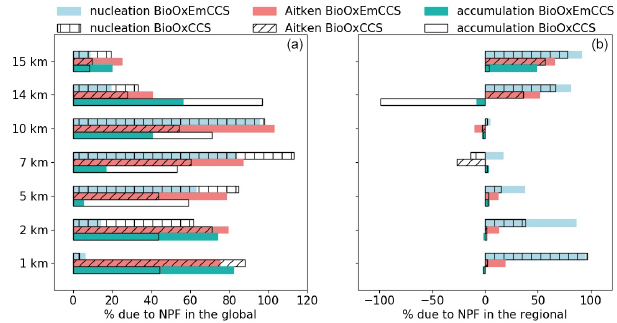
Figure 9. The percentage contribution of NPF to the nucleation, Aitken and accumulation mode aerosol number concentrations from the global model (a) and regional model (b) at various altitudes based on BioOxEmCCS (solid bars) and BioOxCCS (empty bars)